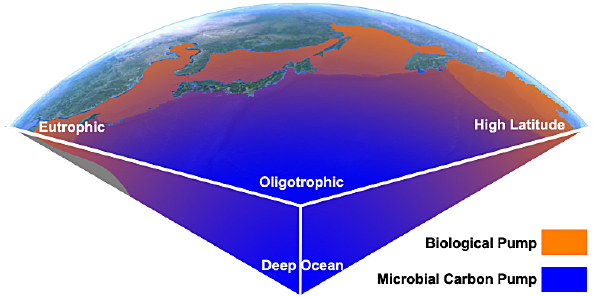
Figure 3. A demonstration of trends in the relative dominance of the BP and the MCP along environmental